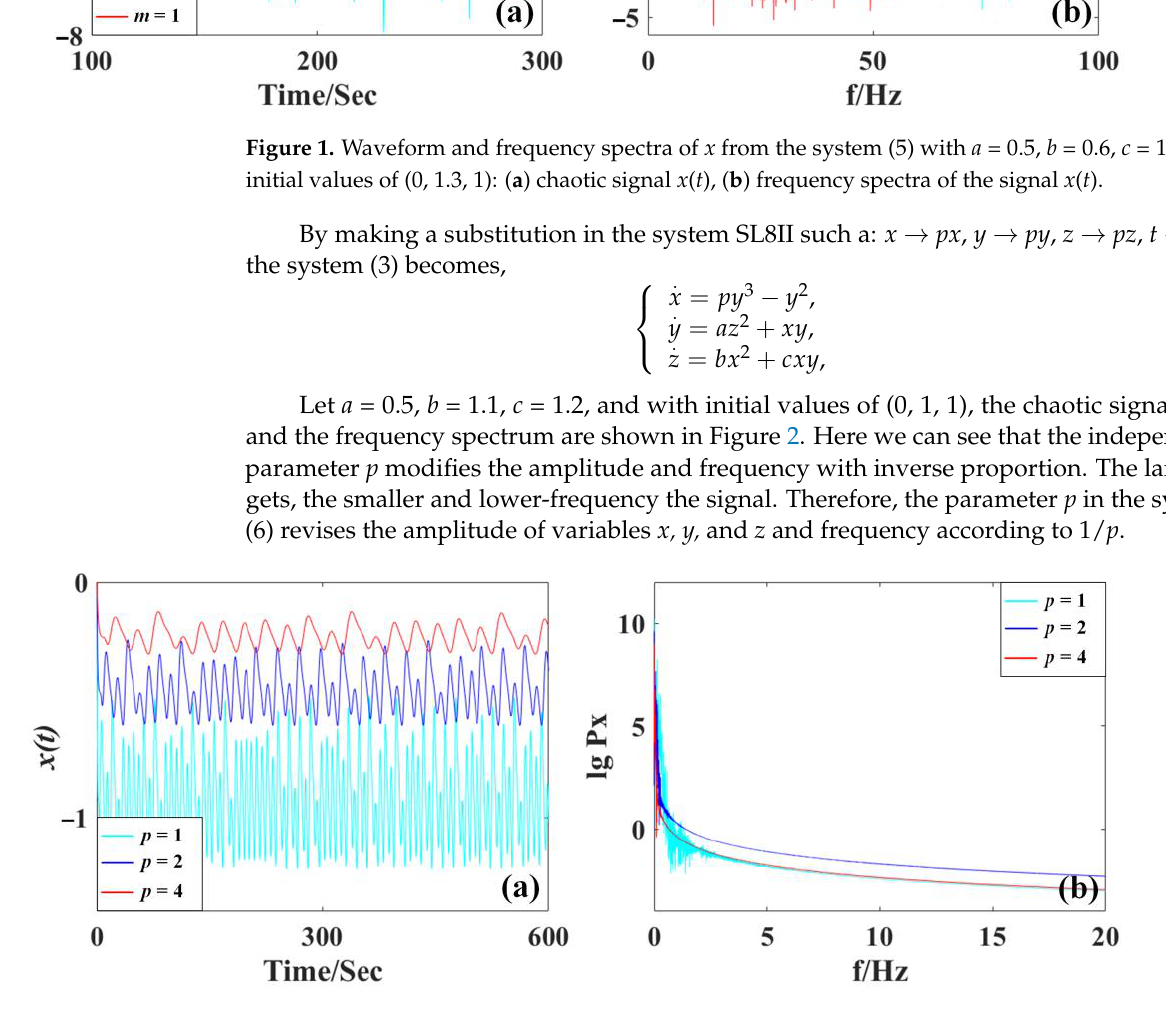
Figure 2. Waveform and frequency spectra of x from the system (6) with a = 0.5, b = 1.1, c = 1.2 and initial values of (0, 1, 1): ( a ) chaotic signal x ( t ), ( b ) frequency spectra of the signal x ( t ).